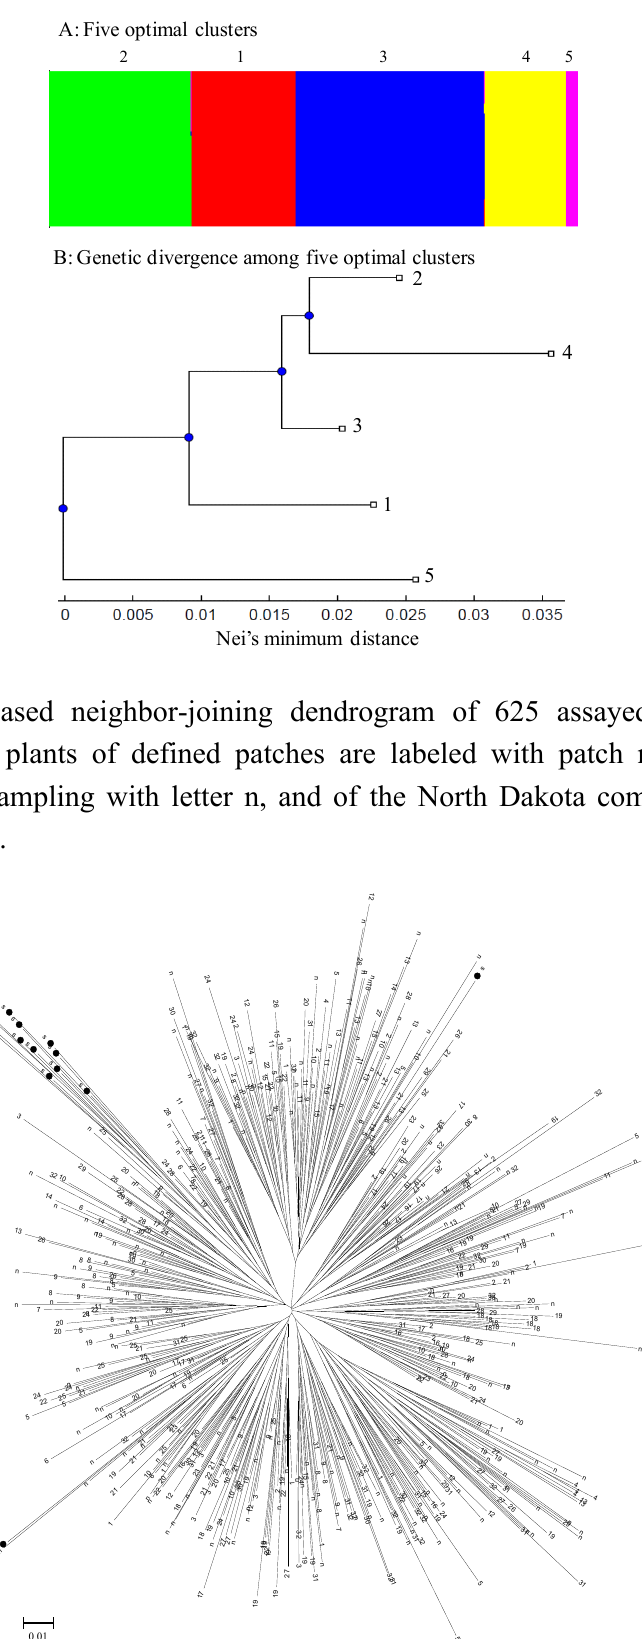
Figure 2. Genetic structure of 625 assayed hairy prairie-clover plants inferred using the BAPS software. ( A ) five optimal clusters; ( B ) genetic divergence among five optimal clusters.